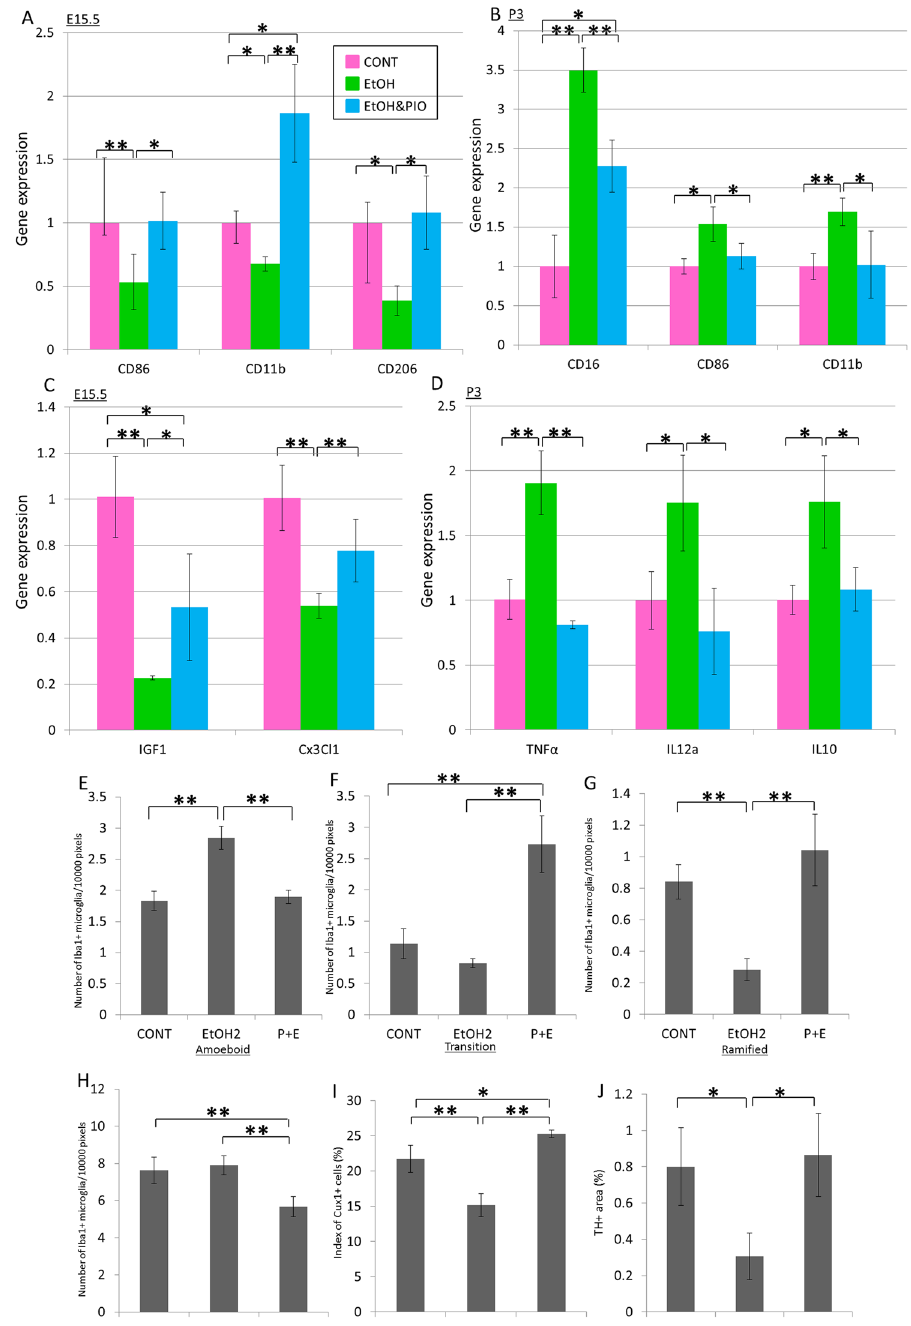
Figure 5. Effect of pioglitazone co-treatment on impaired mRNA expression and abnormal microglial morphology induced by prenatal exposure to EtOH. Co-treatment with pioglitazone attenuated impairments in microglia-associated mRNA expression and microglial morphology resultant from prenatal exposure to 2.0 g∙kg − 1 EtOH (n = 6, respectively). ( A ) Graph depicting the expression of CD86, CD11b , and CD206 mRNA in the dorsal telencephalon of the EtOH, E + P, and control groups at E15.5. ( B ) Graph depicting CD16, CD86 and CD11b mRNA expression at P3. ( C ) Graph depicting IGF1 and Cx3Cl1 mRNA expression at E15.5. ( D ) Graph depicting TNF α , IL12a , and IL10 mRNA expression at P3. Parasagittal sections of the prefrontal cortex were immunostained at P3 for anti-Iba1 antibody to identify and quantity microglial number and morphology. ( E – H ) Graphs depicting the number of amoeboid ( E ), transition ( F ), ramified ( G ), and total microglia ( H ) in the prefrontal cortex on P3. Parasagittal sections of the prefrontal cortex at P3 immunostaining for anti-Cux1 and anti-TH antibodies to identify and quantify layer 2/3 and dopaminergic neurons. Graphs depicting the indices of Cux1 + cells ( I ) and TH + area ( J ) in the prefrontal cortex at P3, * P < 0.05, ** P < 0.01. One-way ANOVAs with Bonferroni’s post hoc test were